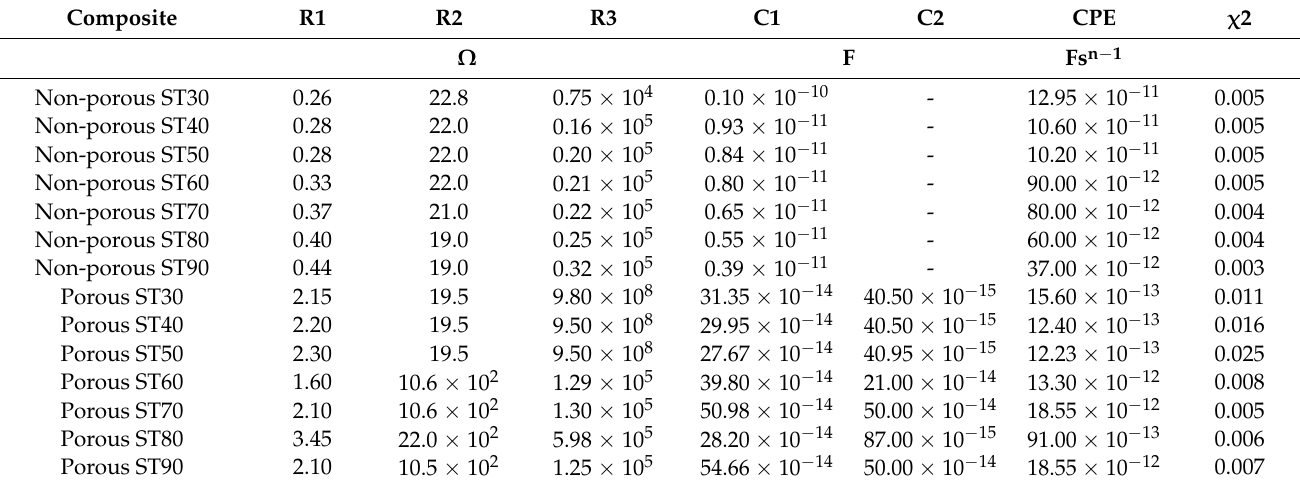
Figure 7. Impedance plot of porous HAp/ST composites with equivalent electrical circuit model (inset). Table 2. Electrical parameters of the equivalent circuit diagram for the non-porous and porous HAp/ST composites.